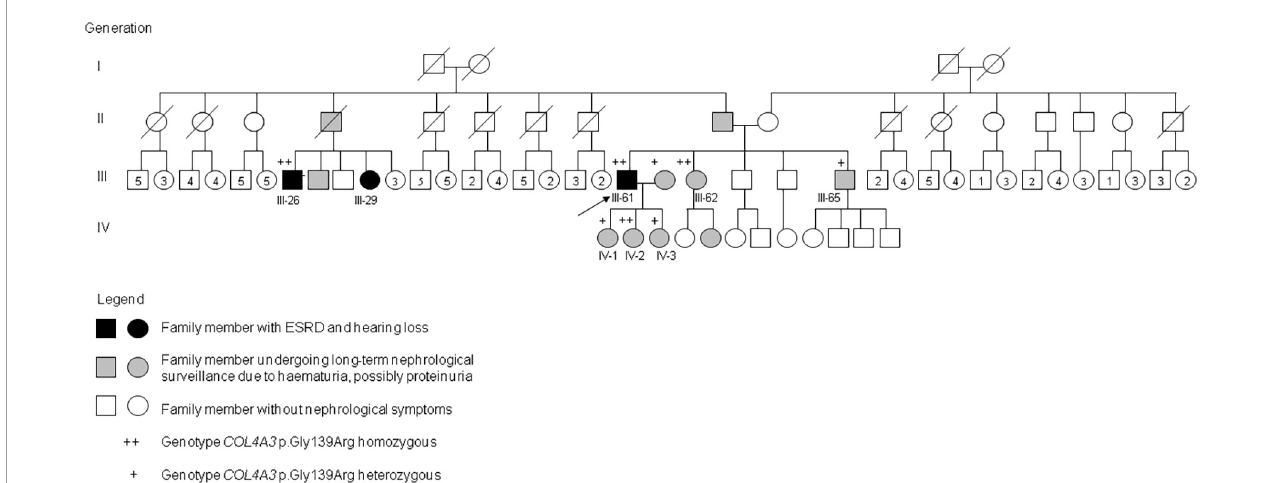
FIGURE1 Pedigree of a Romani family with AR AS due to homozygous COL4A3 c.415G > C, p.Gly139Arg. Genotypes and phenotypes of selected family members: III-26: COL4A3 p.Gly139Arg homozygous; ESRD at 42 years, dialysis, hearing loss, died at 54 years. III-29: no genetic testing; long-term dialysis, age 52 years. III-61: COL4A3 p.Gly139Arg homozygous; ESRD at 17 years, dialysis since 20 years, kidney transplantation at 33 and 41 years, hearing loss at 35 years, lens exchange for anterior lenticonus at 41 years; III-62: COL4A3 p.Gly139Arg homozygous; microscopic hematuria and small proteinuria diagnosed at 10 years, moderate to severe hearing loss since 46 years, normal kidney function at 53 years. III-65: COL4A3 p.Gly139Arg heterozygous; transient acute kidney failure at 41 years after long-term physical and psychical overload, 3 months later isolated microscopic hematuria. IV-1: COL4A3 p.Gly139Arg heterozygous; isolated microscopic hematuria diagnosed at 31 years. IV-2: COL4A3 p.Gly139Arg homozygous; isolated microscopic hematuria diagnosed at 20 years. IV-3: COL4A3 p.Gly139Arg heterozygous; isolated microscopic hematuria diagnosed at 22 years.